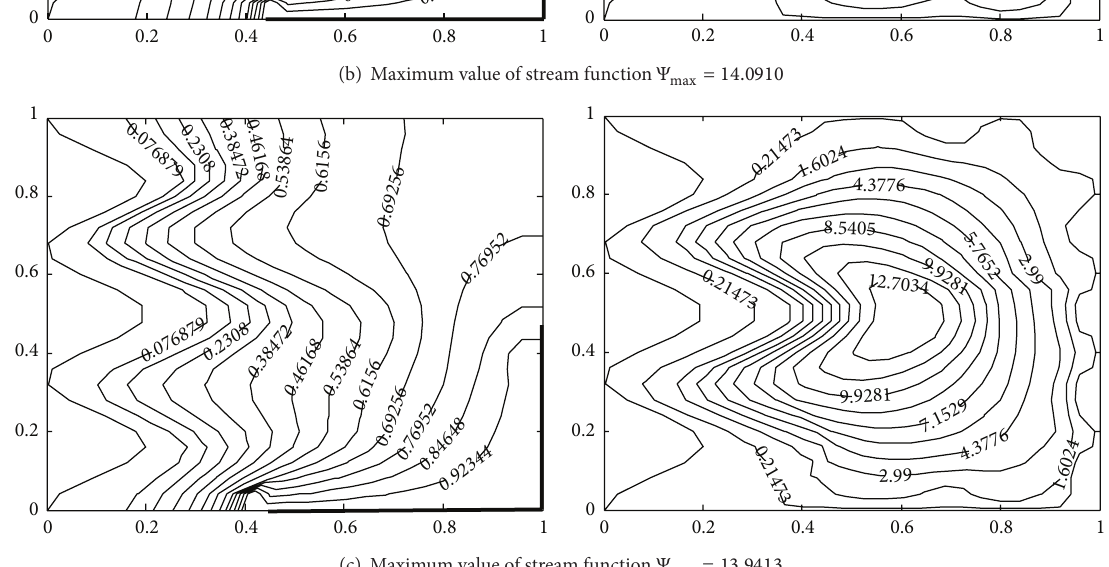
(c) Maximum value of stream function Ψ max = 13.9413 Figure9:Temperaturecontours(ontheleft)andstreamlines(ontheright)withdifferentnumbersofundulationsofwavysurfaceatRa = 10 5 , Pr = 0.7 , 𝐴 = 0.2 , ℎ𝑥 = 0.55 , ℎ𝑦 = 0.55 , (a) 𝑛 = 1 , (b) 𝑛 = 2 , and (c) 𝑛 = 3